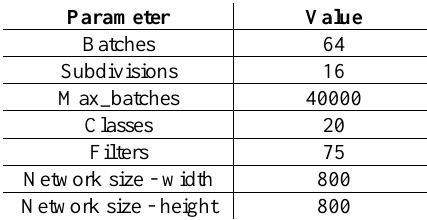
Table 3. Parameters adjusted for the DIOR dataset used during learning YOLO network.